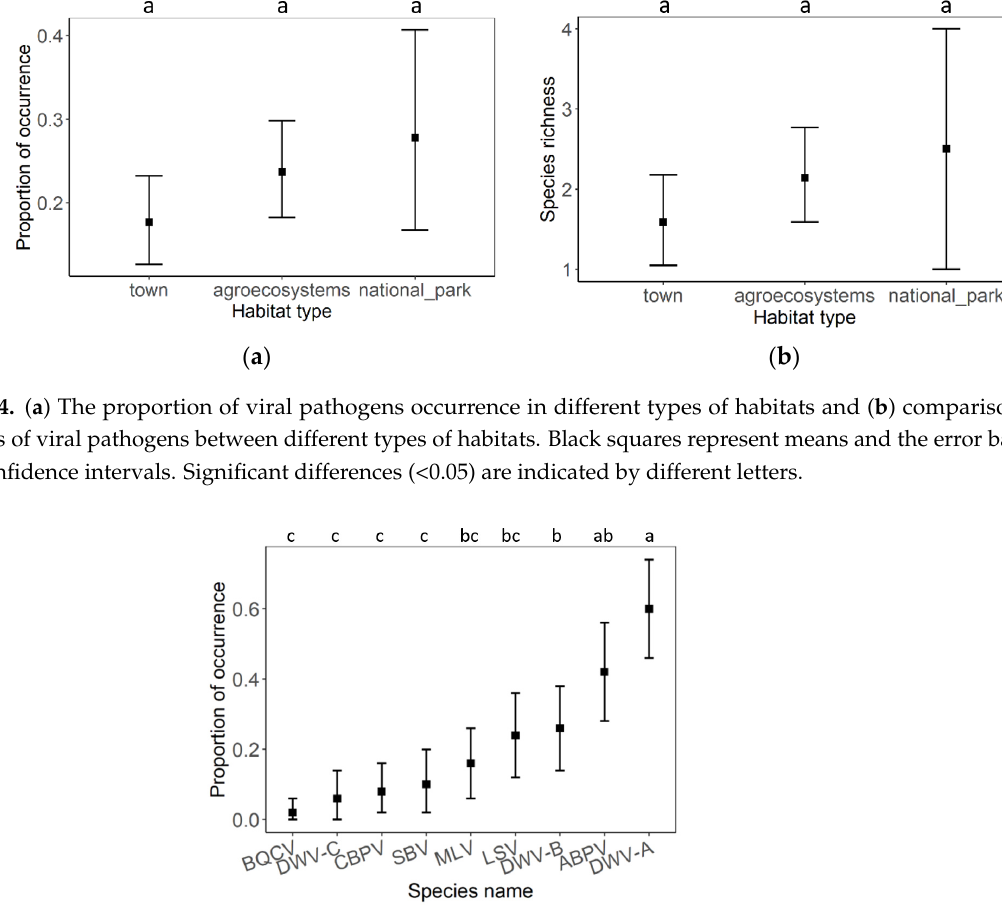
Figure 5. The comparison of proportion of viral pathogen occurrence regardless of habitat. Black squares represent means and the error bars represent 95% confidence intervals. Significant differences (<0.05) are indicated by different letters.